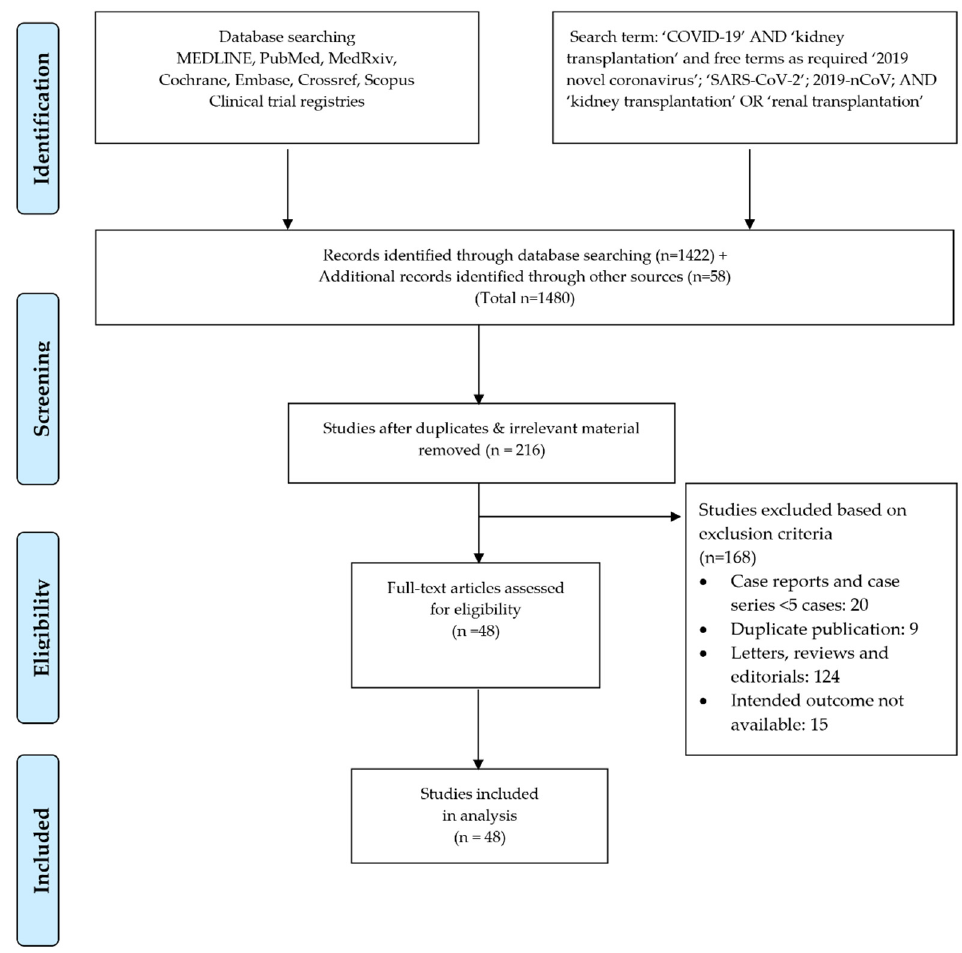
Figure 1. Search strategy and study selection used in this systematic review as per the PRISMA